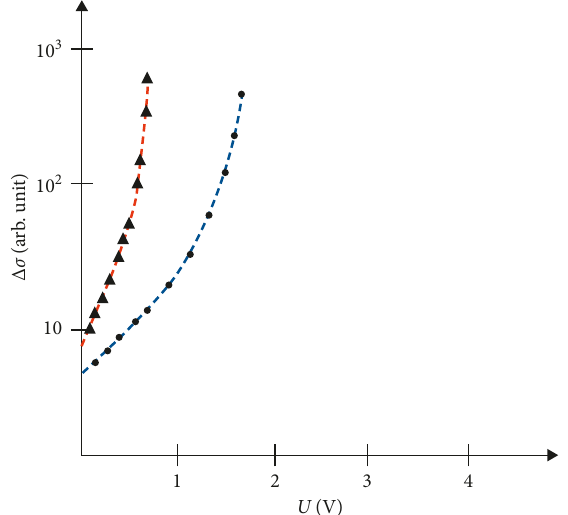
Figure 16: Dependence of the CR PES lines of the sample 6 on the applied voltage U at T curves marked by and • correspond to the case of ε